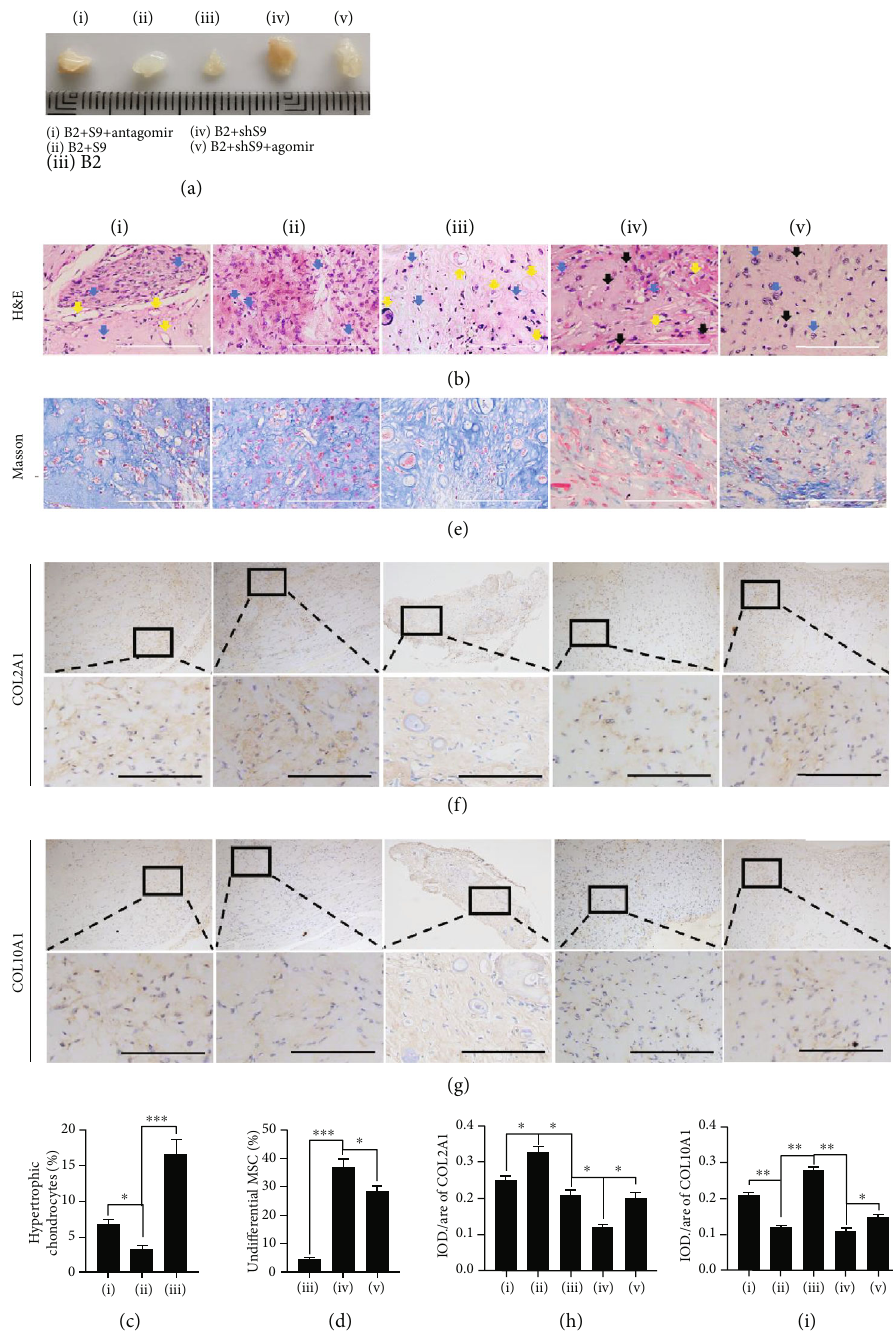
Figure 7: BMP2-induced chondrogenesis was enhanced, and chondrocyte hypertrophy was weakened by miR-322-5p in vivo. (a) Masses were retrieved after 4 weeks of injection. (b) Overexpressing Sox9 decreased the number of hypertrophic chondrocytes (yellow arrow), which was partly reversed by the use of the miR-322-5p antagomir ((b) i – iii); moreover, silencing Sox9 decreased the number of di ff erentiated chondrocytes (blue arrow) and increased the number of undi ff erentiated MSCs (dark arrow), which was partly reversed by forced expression of the miR-322-5p agomir ((b) iii – v). (c, d) Quantitative analysis of randomized three fi elds in each group. (e) According to the Masson staining, increased formation of cartilage tissue promoted by Sox9 was partly reversed by adding of miR-322- 5p antagomir, while decreased production of cartilage tissue caused by silencing Sox9 was partly reversed by forced expression of miR- 322-5p agomir. (f, g) IHC showed that overexpression of Sox9 increased the synthesis of COL2A1 and decreased the generation of COL10A1, and both were partly reversed by use of miR-322-5p antagomir; simultaneously, silence of Sox9 decreased the production of COL2A1 and increased the formation of COL10A1, and both were partly reversed by use of miR-322-5p agomir. (h, i) Quantitative analysis of positive-stained area. Integral optical density/area (IOD/area) was calculated with Image Pro Plus software. Scale bar = 150 μ m; ∗ p < 0 : 05 , ∗∗ p < 0 : 01 , and ∗∗∗ p < 0 : 001